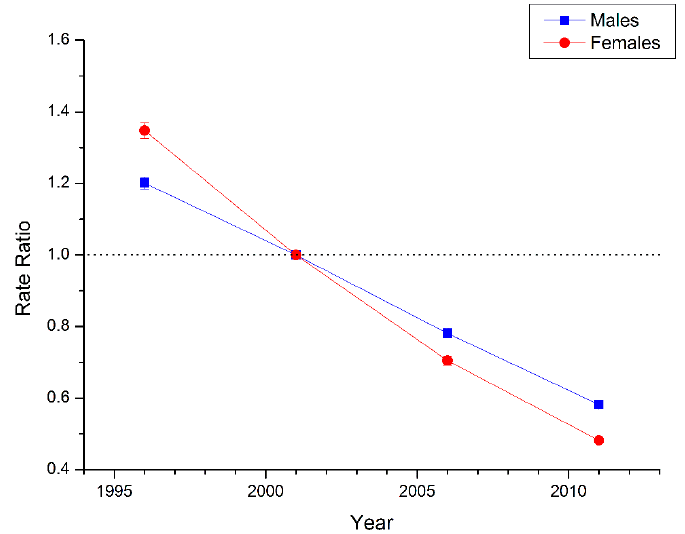
Figure 4. Period RRs of suicide rate by gender in China. Period effects obtained from age-period-cohort analyses for the suicide rates and the corresponding 95% confidence intervals (some of them were too narrow to show in the figure) by gender in China.